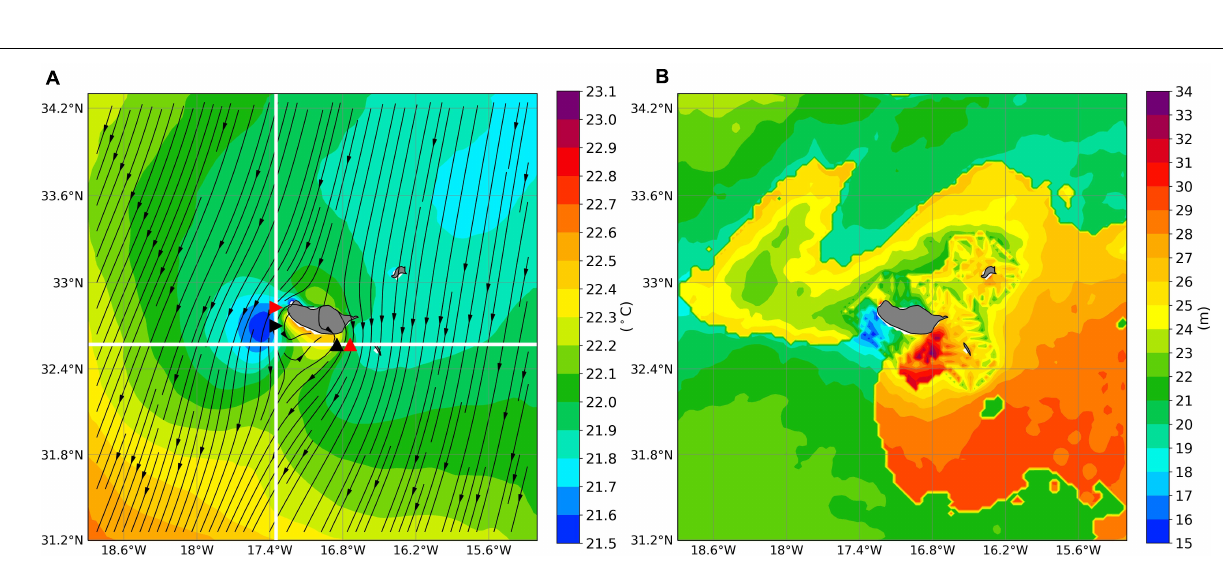
Frontiers in Marine Science |